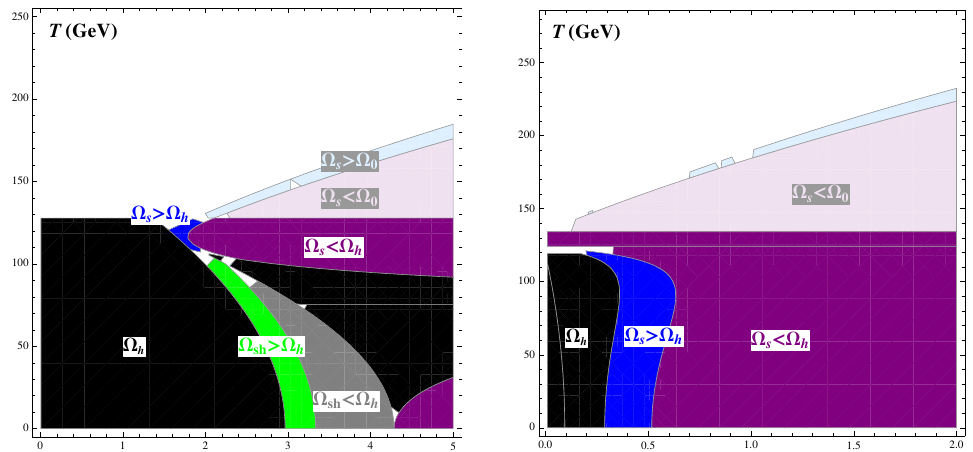
Figure 5 . Vacuum structure evolution under the high temperature approximation ( (cid:17) > 0 case). (Left panel): (cid:21) sh = 0 : 37, (cid:21) s = 1 and m s = 95 GeV; (Right panel): (cid:21) sh = 0 : 7 and (cid:21) s = 1 and m s = 115